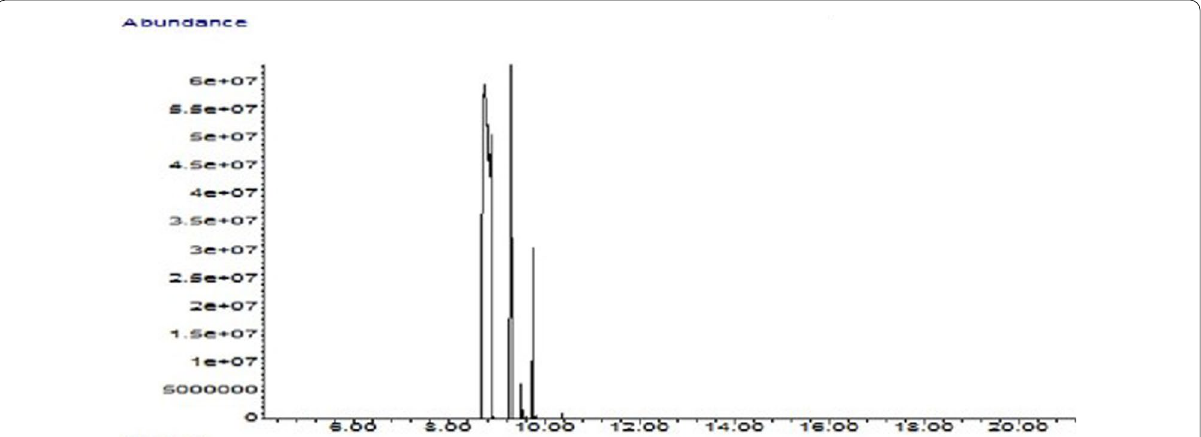
Fig. 2 GC mass chromatogram of EOSA. The majority compounds of EOSA are eugenol (77.322%, Tr